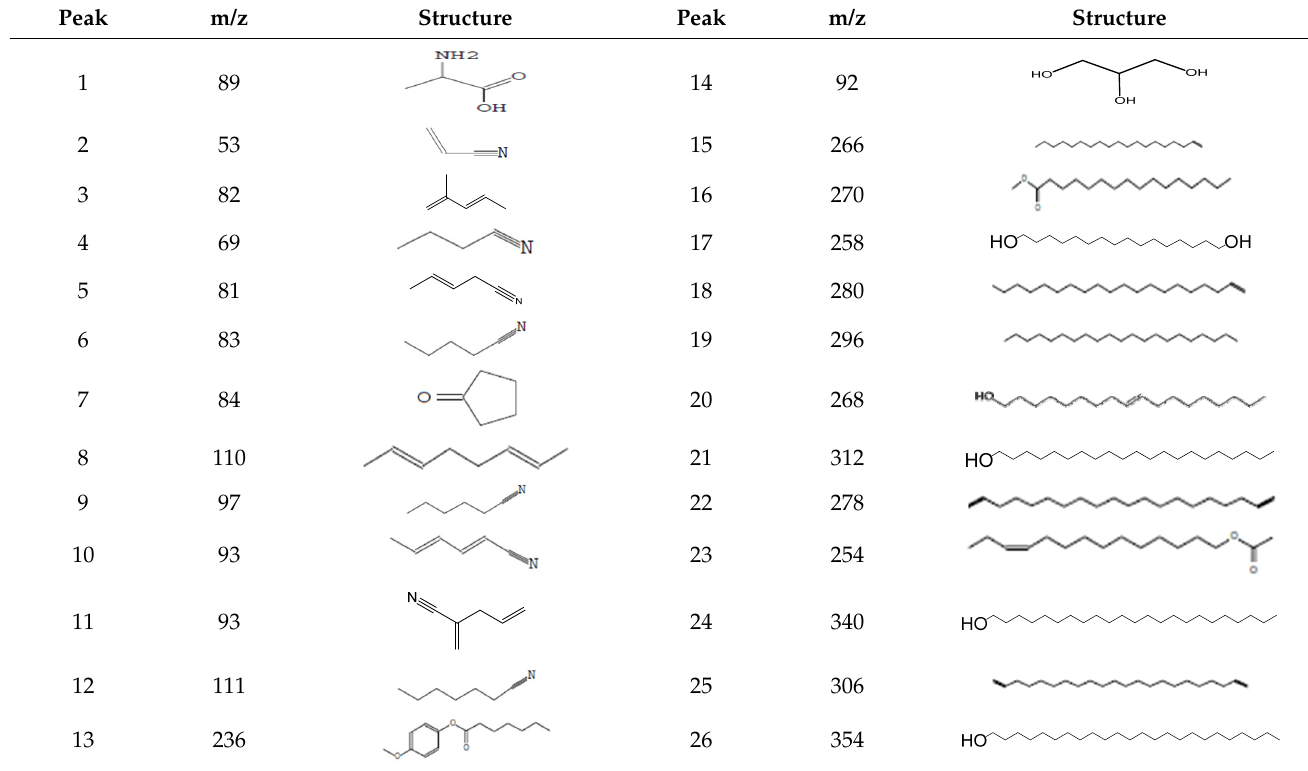
Table 8. Attribution of peaks in PY − GC − MS results of PA6/13%Mic − DP.